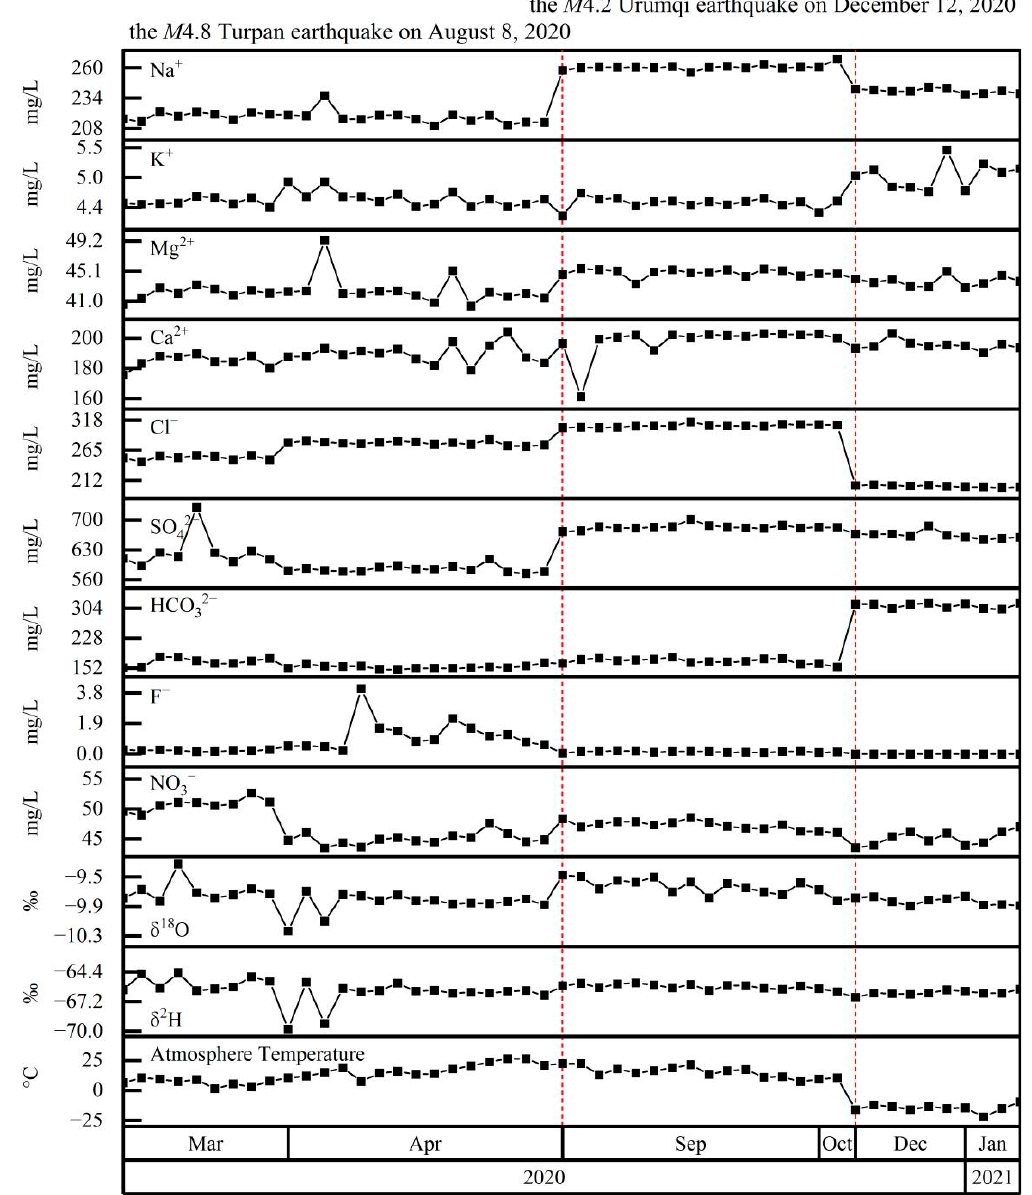
Figure 3. Time series of Spring 15 major ion concentrations (Na + , K + , Mg 2+ , Ca 2+ , Cl − , SO 42 − , HCO 3 − , F − , and NO 3 − ), stable isotopes ( δ 2 H, δ 18 O), and atmospheric temperature. Red-dashed lines mark the occurrence of potentially significant earthquakes within the study area.